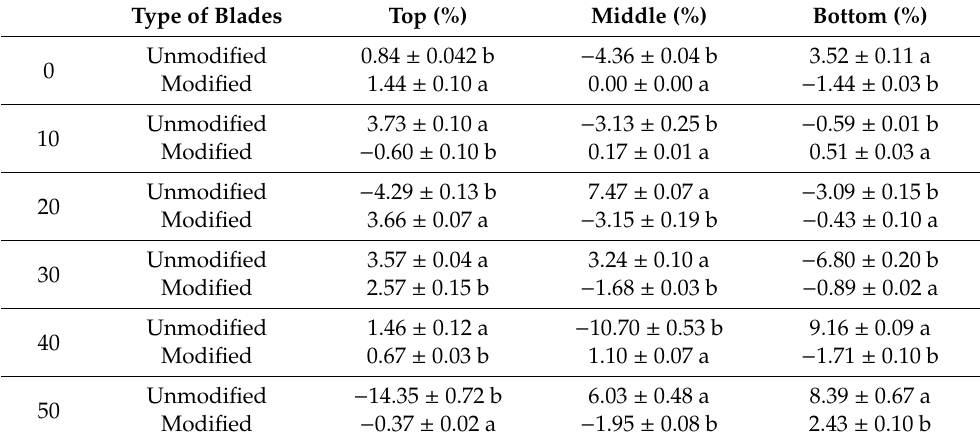
Table 1. Distribution over time of the separable fat content within the